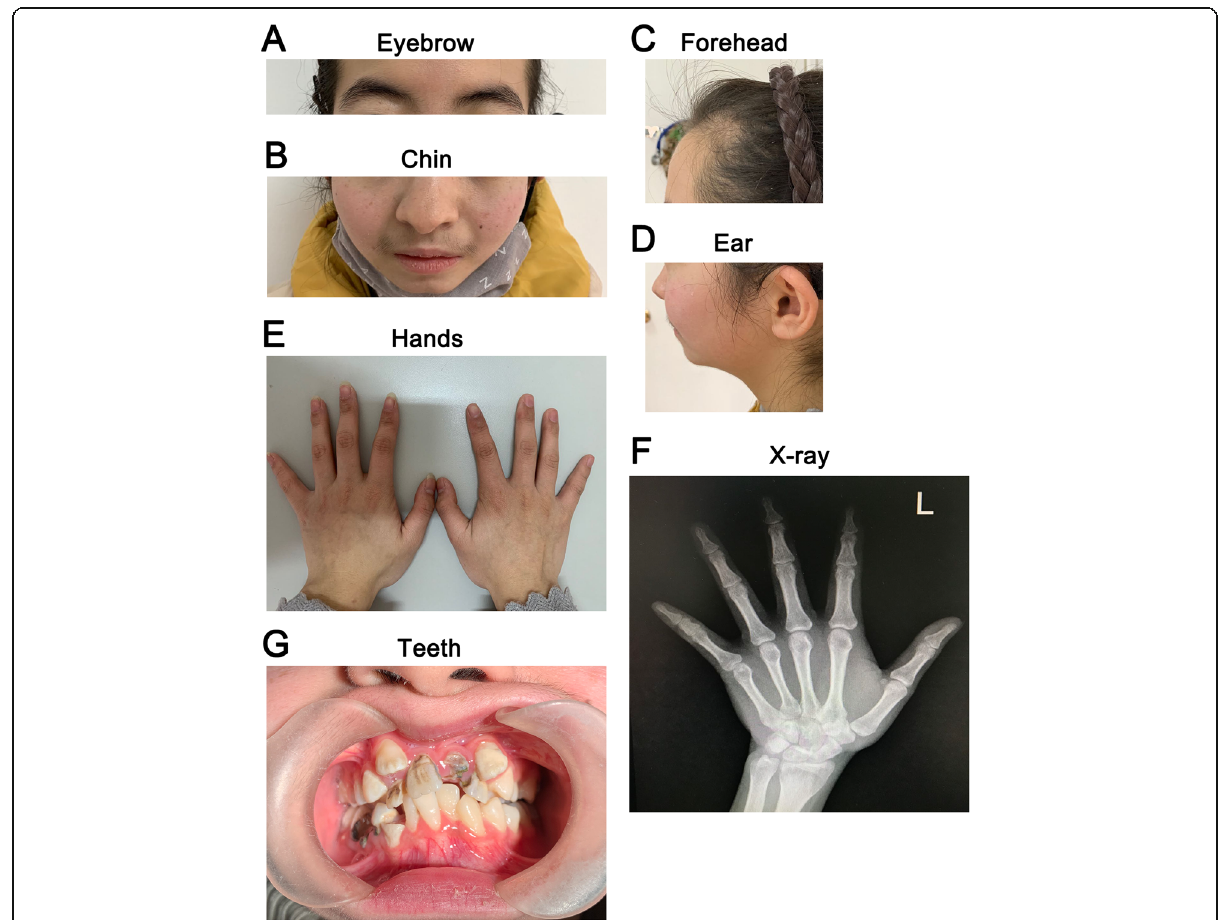
Fig. 1 Image of the patient. a , b , c , d . Facial abnormalities included triangular face with a small chin, thin lip, downturned mouth, low-set posteriorly rotated ears, obvious beard and bushy eyebrows. e , f . Thicken and short second phalanx of little finger in the left hand. g . Overcrowded and irregular teeth, multiple dental caries